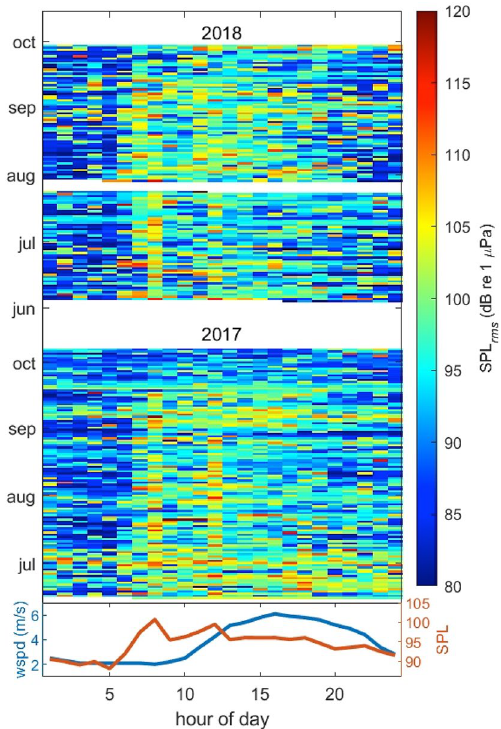
Figure 3. Median noise levels (root mean square sound pressure levels—SPL rms ) for each hour of each day recorded on a hydrophone (50–10,000 Hz) deployed outside the Newport harbor entrance during June to October of 2017 (middle plot) and 2018 (upper plot), and hourly median noise level (SPL) against hourly median wind speed (lower plot) from an anemometer station located on South Beach, Newport, Oregon, USA (station NWPO3) over the same time